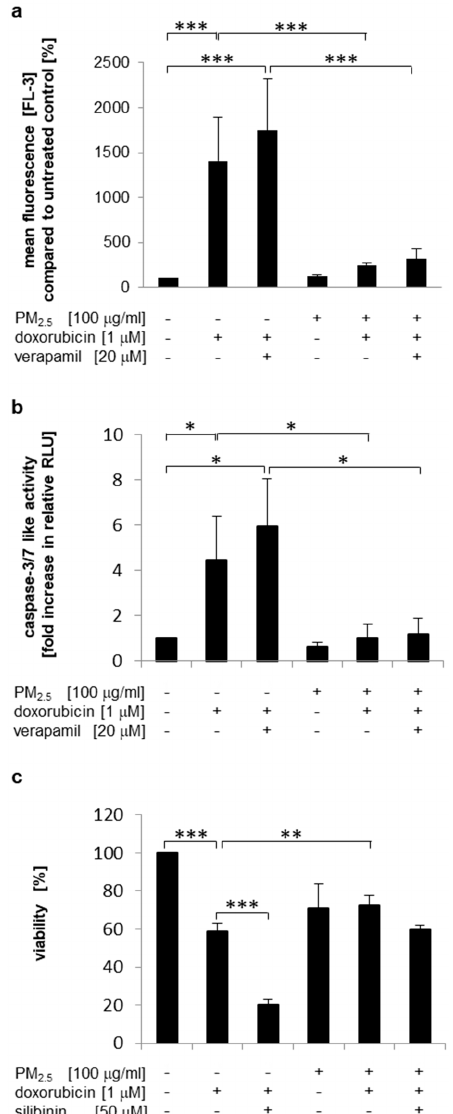
Figure 6. P-gp is not involved in PM 2.5 -mediated doxorubicin resistance. BEAS-2B cells were cultured in the presence of 100 µg/mL PM 2.5 for 3 to 5 weeks, before final passage and re-exposure of cells to 100 µg/mL PM 2.5 for 48 h. Verapamil (20 µM) or silibinin (50 µM) were added 1 h prior to the last exposure to PM 2.5 , doxorubicin (1 µM) was added 24 h after the last exposure to PM 2.5 . Cells that were never exposed to PM 2.5 served as controls. ( a ) Quantification of the intracellular doxorubicin content by flow cytometry. Mean fluorescence values (FL3) were compared to untreated cells (n = 4). ( b ) Detection of apoptosis by a caspase 3/7 activity assay (n = 3). ( c ) Cell viability determination by an MTT assay (n = 3). RLU: relative light units. Values are depicted as means and +standard deviations; * p < 0.05; ** p < 0.01; *** p < 0.001.